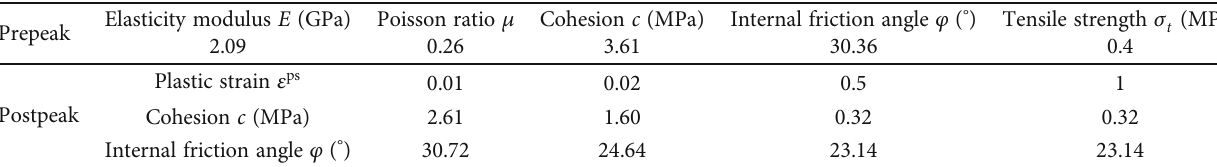
Table 1: Calibrated parameters of the rock masses.